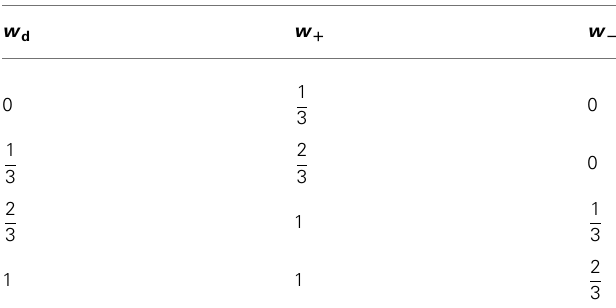
Table 2 | Example look-up table for a weight resolution of r = 2 bits and n = 100